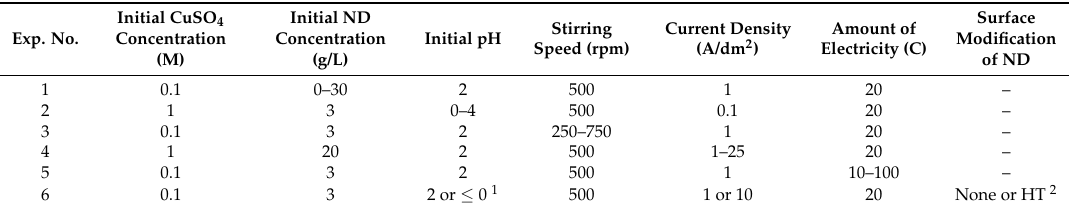
Table 1. Coating conditions used in this